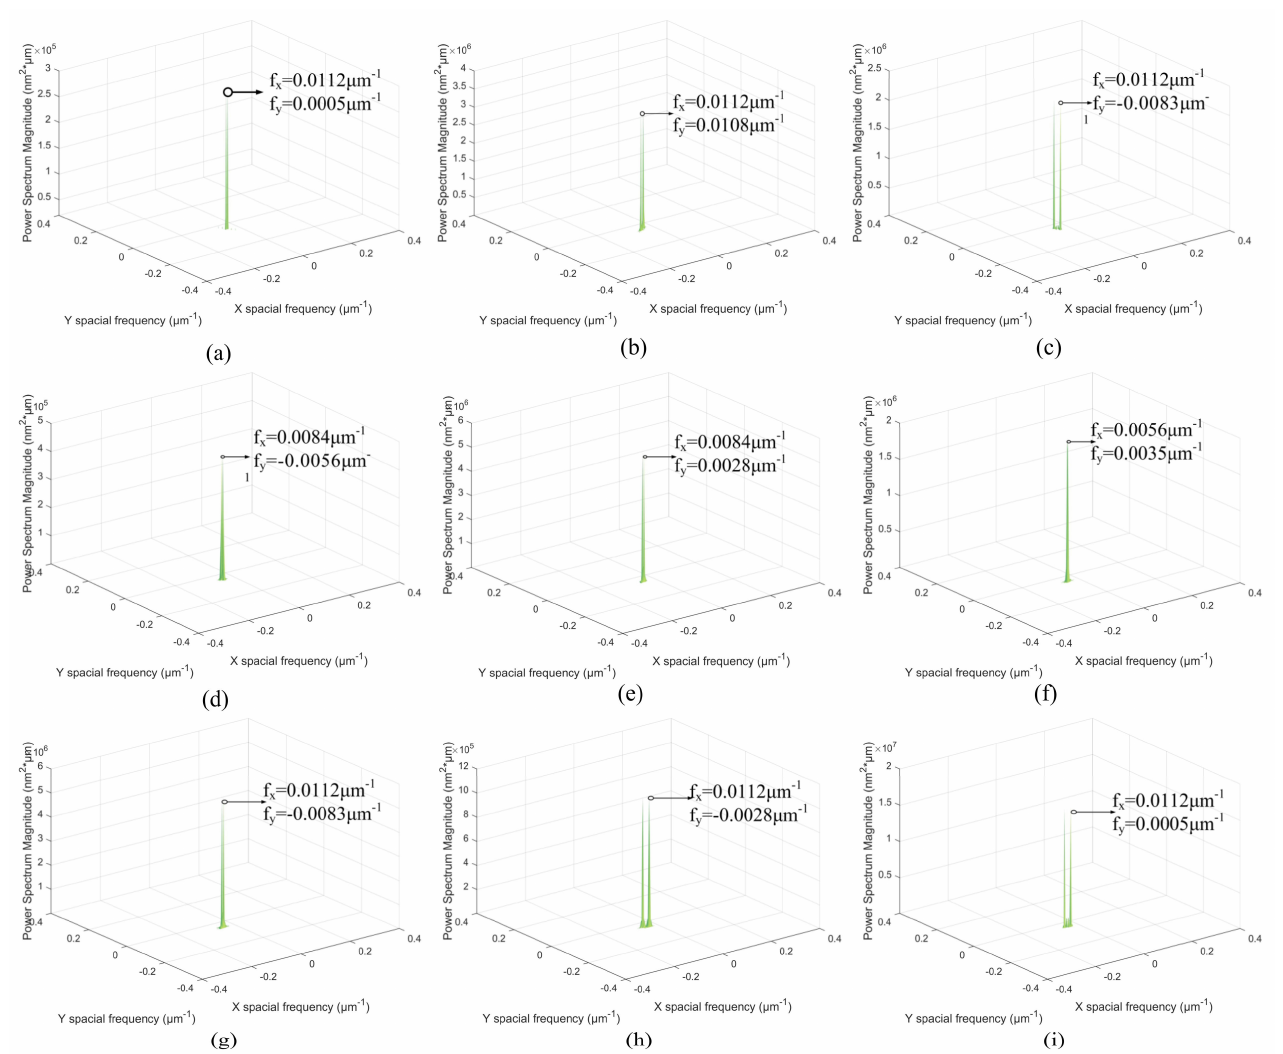
Figure 10. The 2D PSD results of reconstructed frequency features: ( a ) middle-frequency of a p = 3 µ m, ( b ) middle-frequency of a p = 6 µ m, ( c ) middle-frequency of a p = 9 µ m, ( d ) low-frequency of f = 8 µ m/r, ( e ) low-frequency of f = 12 µ m/r, ( f ) low-frequency of f = 18 µ m/r, ( g ) middle-frequency of n = 1300 r/min, ( h ) middle-frequency of n = 1400 r/min, ( i ) middle-frequency of n = 1500